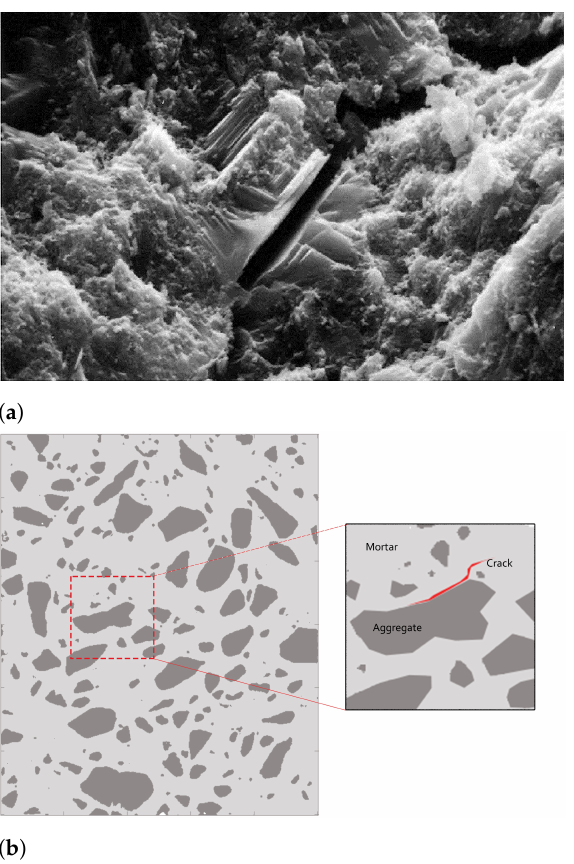
Figure 1. Microphotography of a crack in mortar ( a ) and its schematic representation ( b